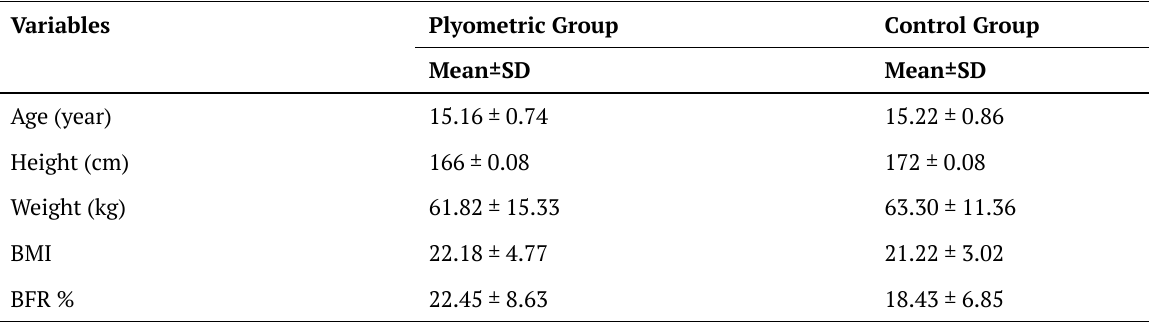
Table 2. Anthropometric characteristics of the